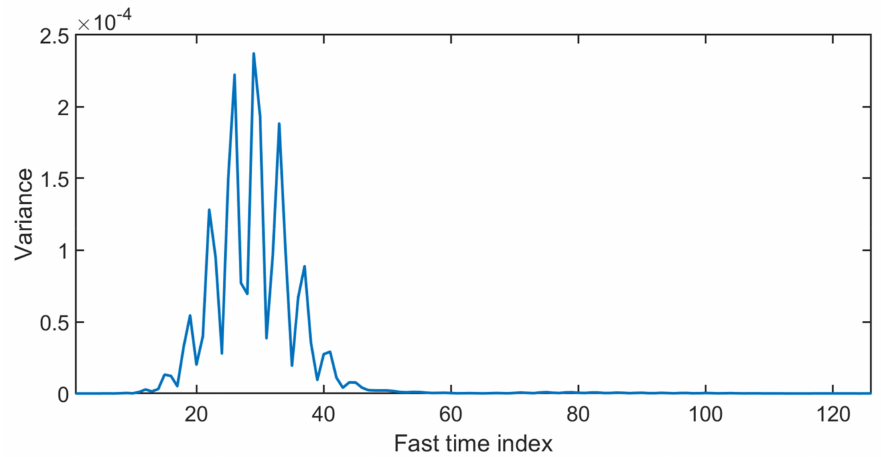
Figure 4. The variance of the signal at di ff erent slow time indexes.